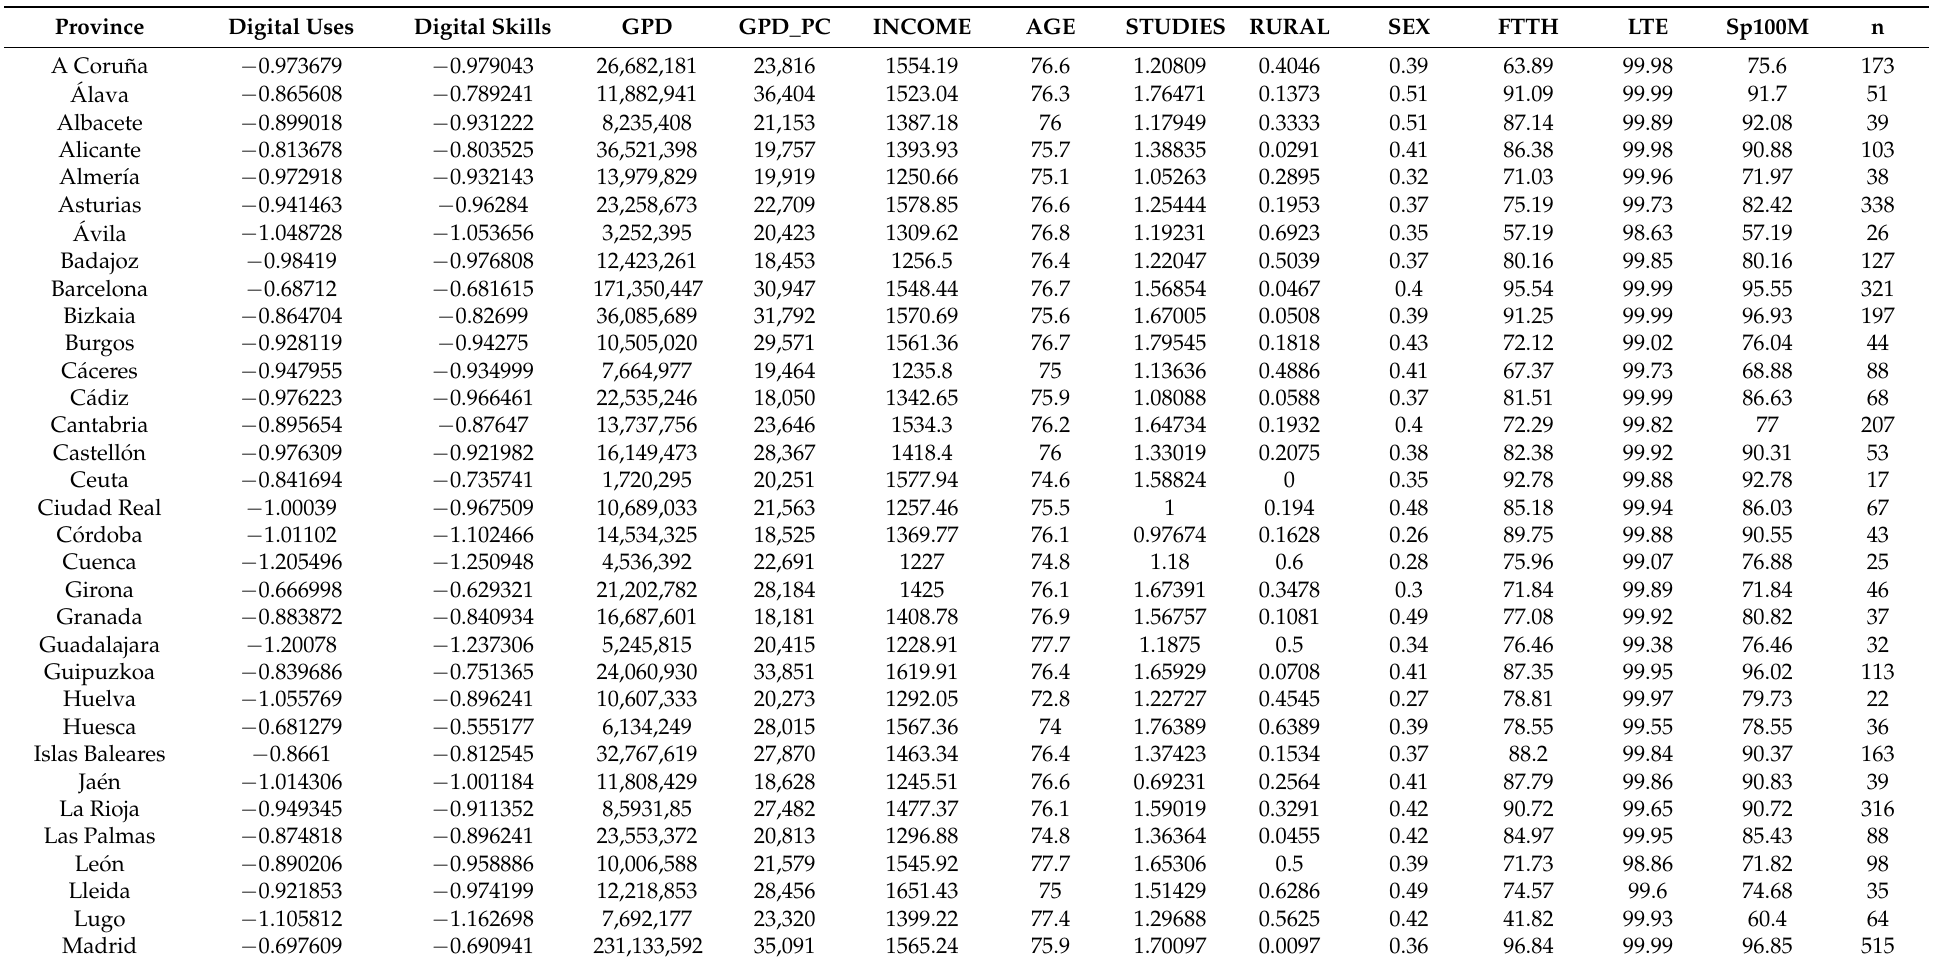
Table A23. Senior